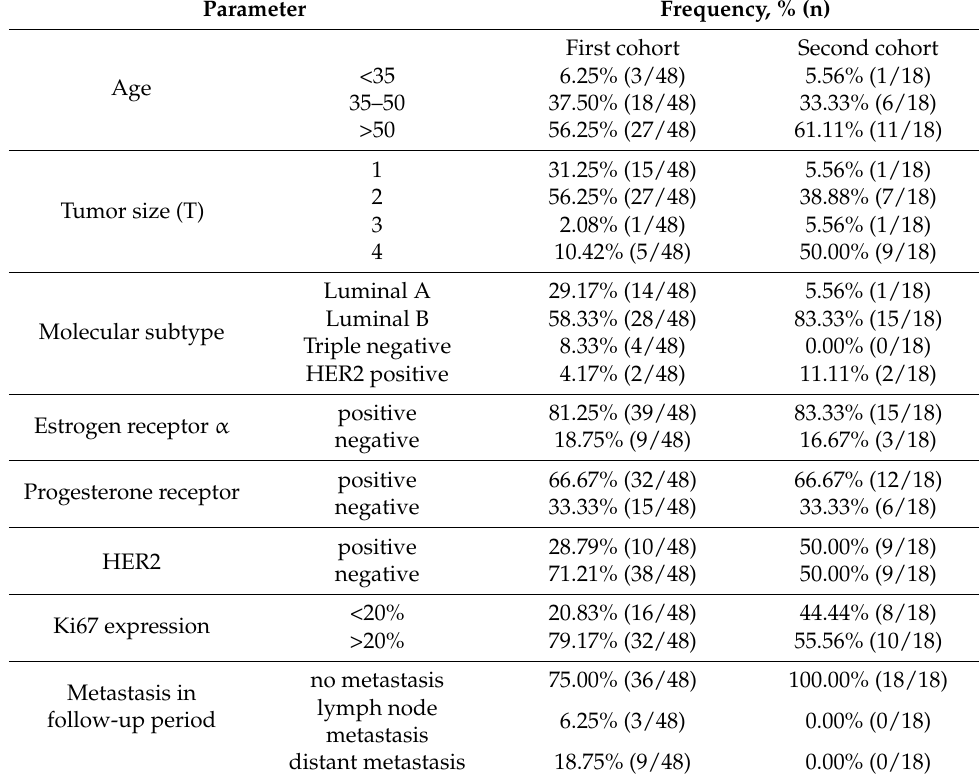
Table 1. Clinicopathological characteristics of